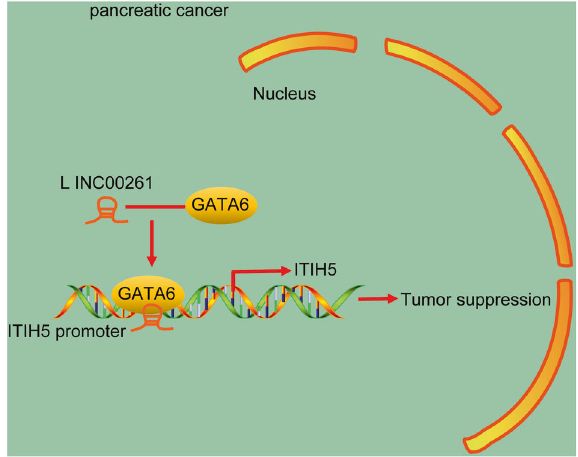
Fig. 8 The molecular mechanism by which LINC00261 acts in PC. In the presence of LINC00261, GATA6 is recruited to the ITIH5 promoter region, promoting ITIH5 expression and thereby attenuat- ing biological characteristics such as cell proliferation, self-renewal, and invasion and promotes sensitivity to gemcitabine of PC stem cells and ultimately reducing their